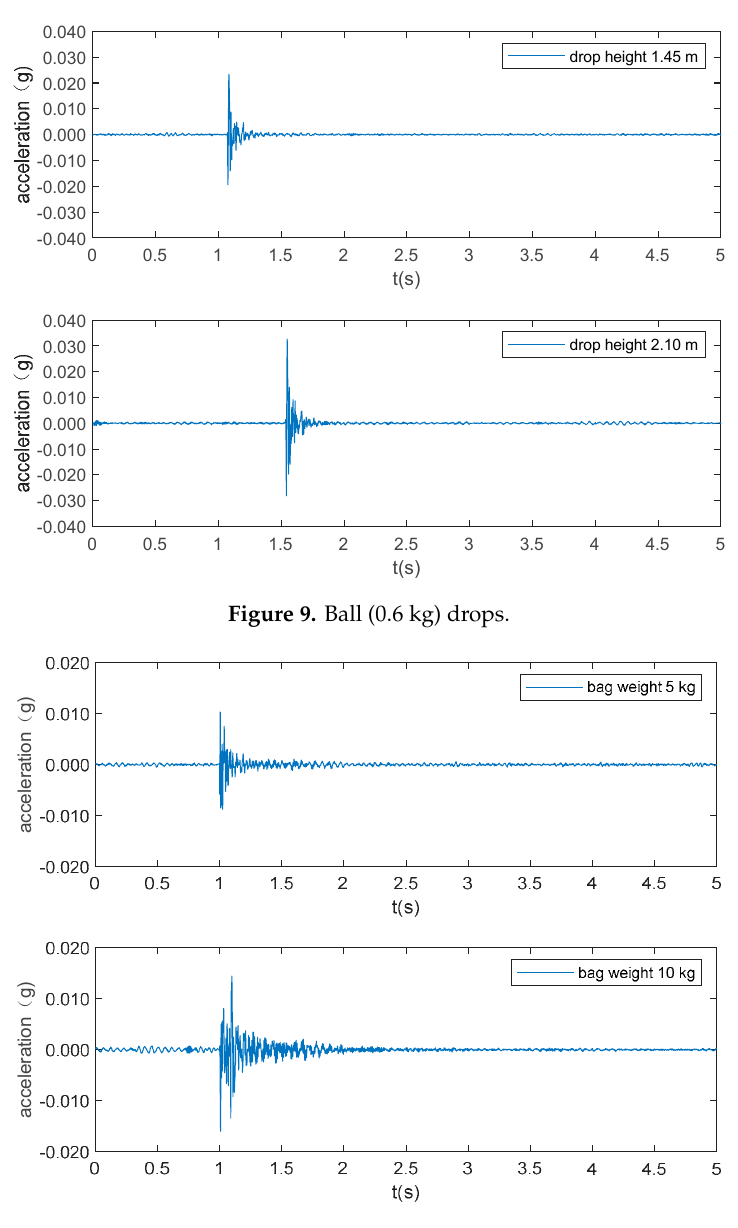
Figure 10. Bag (5 kg and 10 kg)